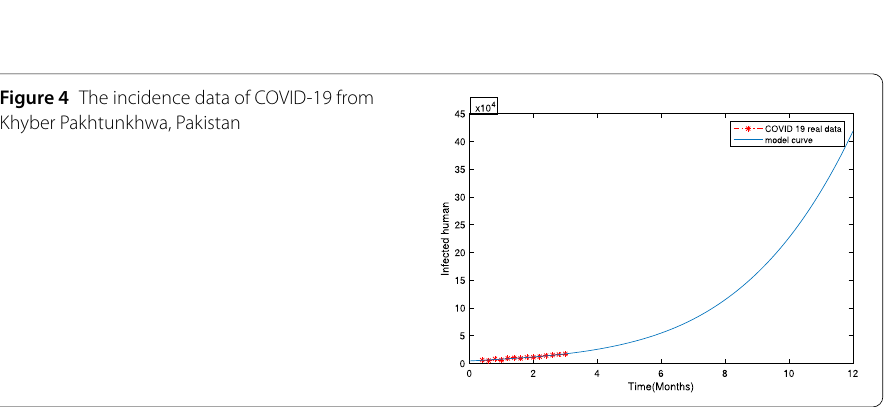
Figure 3 Profiles for the second set of initial conditions at different χ values i.e. χ = 0.50,0.55,0.60,0.65,0.70, 0.75,0.80,0.85,0.90, and α = 0.2